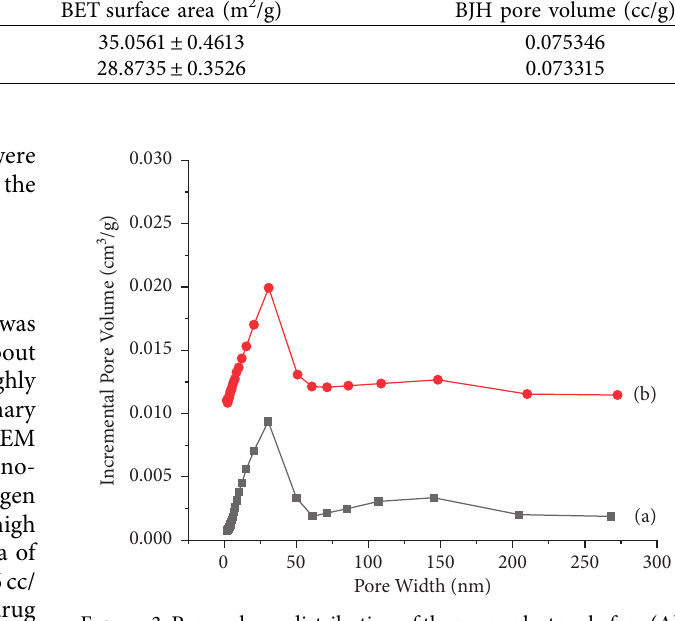
Figure 2: SEM images of the porous lactose particles before (a) and after (b) quercetin loading. Table 1: Pore features of the porous lactose before and after quercetin loading. BET surface area (m 2 /g) BJH pore volume (cc/g)